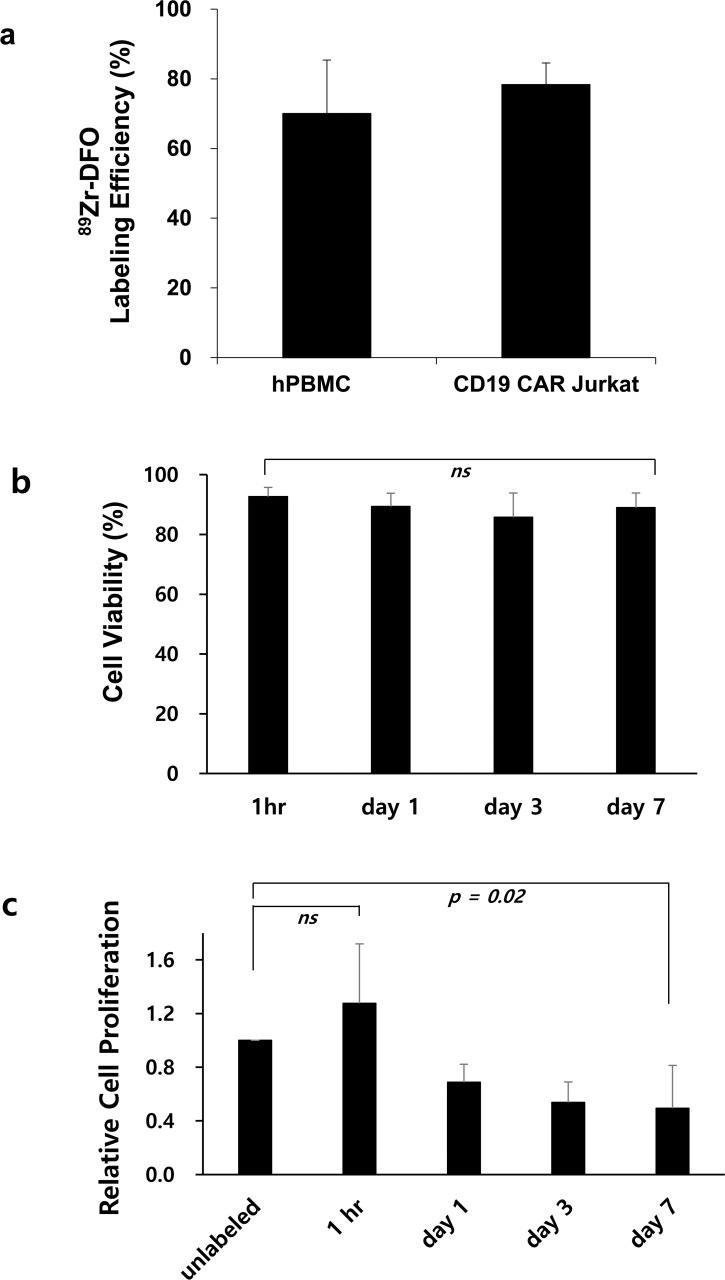
89Zr-DFO-labeled CAR T-cells labeling efficiency, cell viability and relative cell proliferation.a hPBMC CAR T-cells labeling efficiency after 89Zr-DFO labeling. b The cell viability was measured up to seven days after cell labeling c Relative cell proliferation of the labeled CAR T-cells was compared to that of the unlabeled. Data are representative of at least three independent experiments. All data are expressed as the mean and standard deviation.